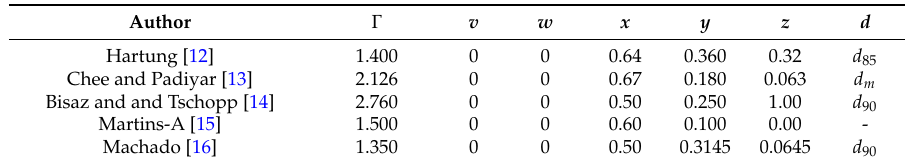
Table 2. Coefficients of five simplified scour formulae.